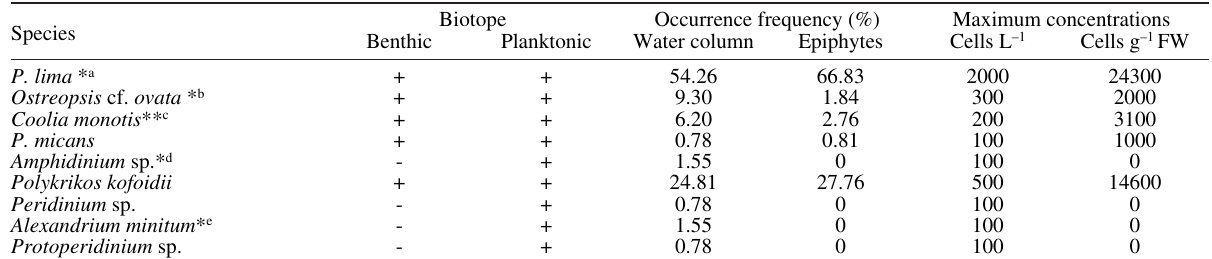
Table 5. – Mean abundance (relative to total dinoflagellates) and seasonal percentages (%) (relative to total epiphyte microalgae) of the epiphytic toxic dinoflagellates sampled on various substrates. MA, mean abundance.